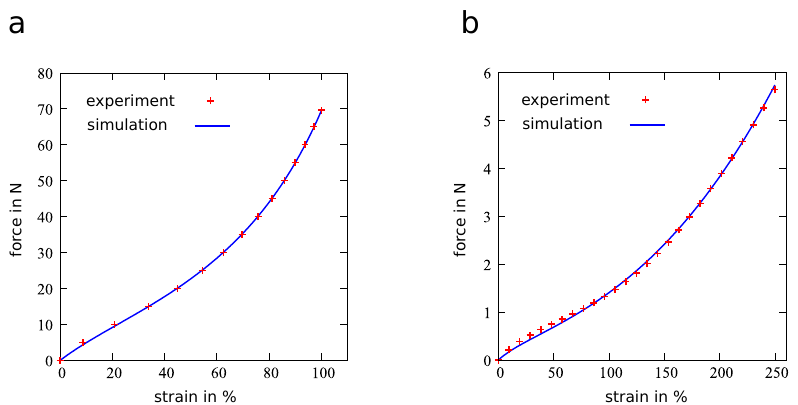
Figure 7. Fitted simulation and experimental results for specimens from ( a ) Sylgard 184 material with DIN EN ISO 527-2 and ( b ) Elastosil 2030 material with a size of 104 mm × 20 mm × 0.1 mm.